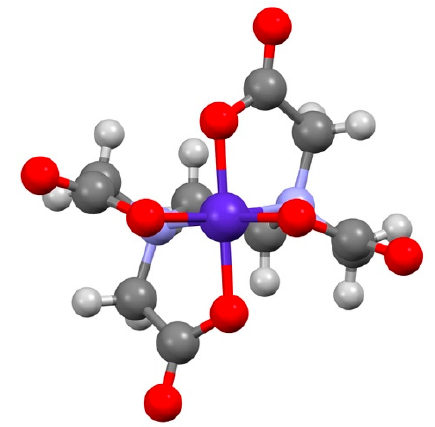
Figure 2. View down the molecular C 2 -axis of ∆ Λ ∆ -[Co(edta)] − showing how it is flanked by the carboxylate pseudo- C 3 -faces.